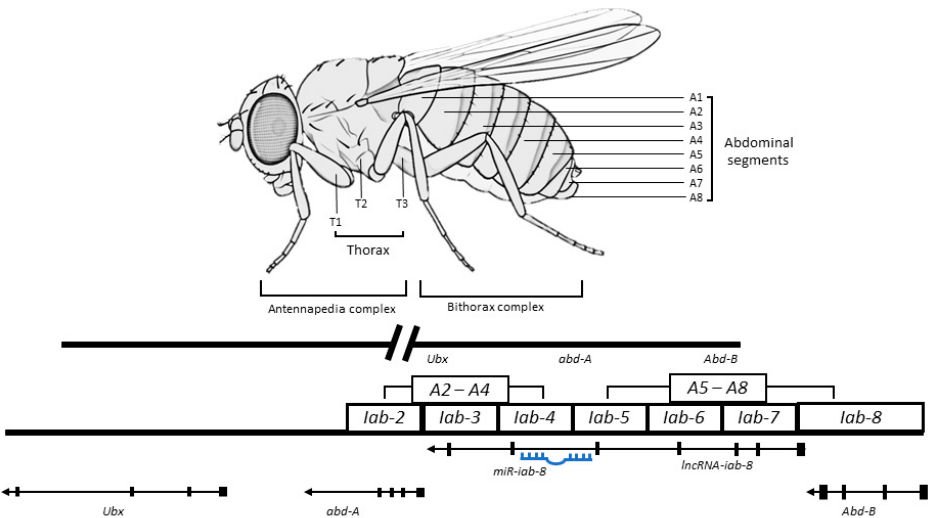
Figure 4. Schematic diagram of the bithorax complex (BX-C) and the lncRNA- iab-8 . The segment- specific domains are presented in rectangles. The lncRNA- iab-8 encodes from the intergenic region between the abd-A and Abd-B genes. It is expressed in neural cells from the eighth abdominal segment and regulates the expression of abd-A . The lncRNA- iab-8 regulates via acting as a precursor for miR-iab-8 production or by controlling transcriptional interference of the abd-A promotor in a cis manner [71] Note: Figure adapted with permission from Daniel L. Garaulet, Eric C. Lai, Mechanisms of Development; published by Elsevier, 2015. Copyright license no. 5462280266230.